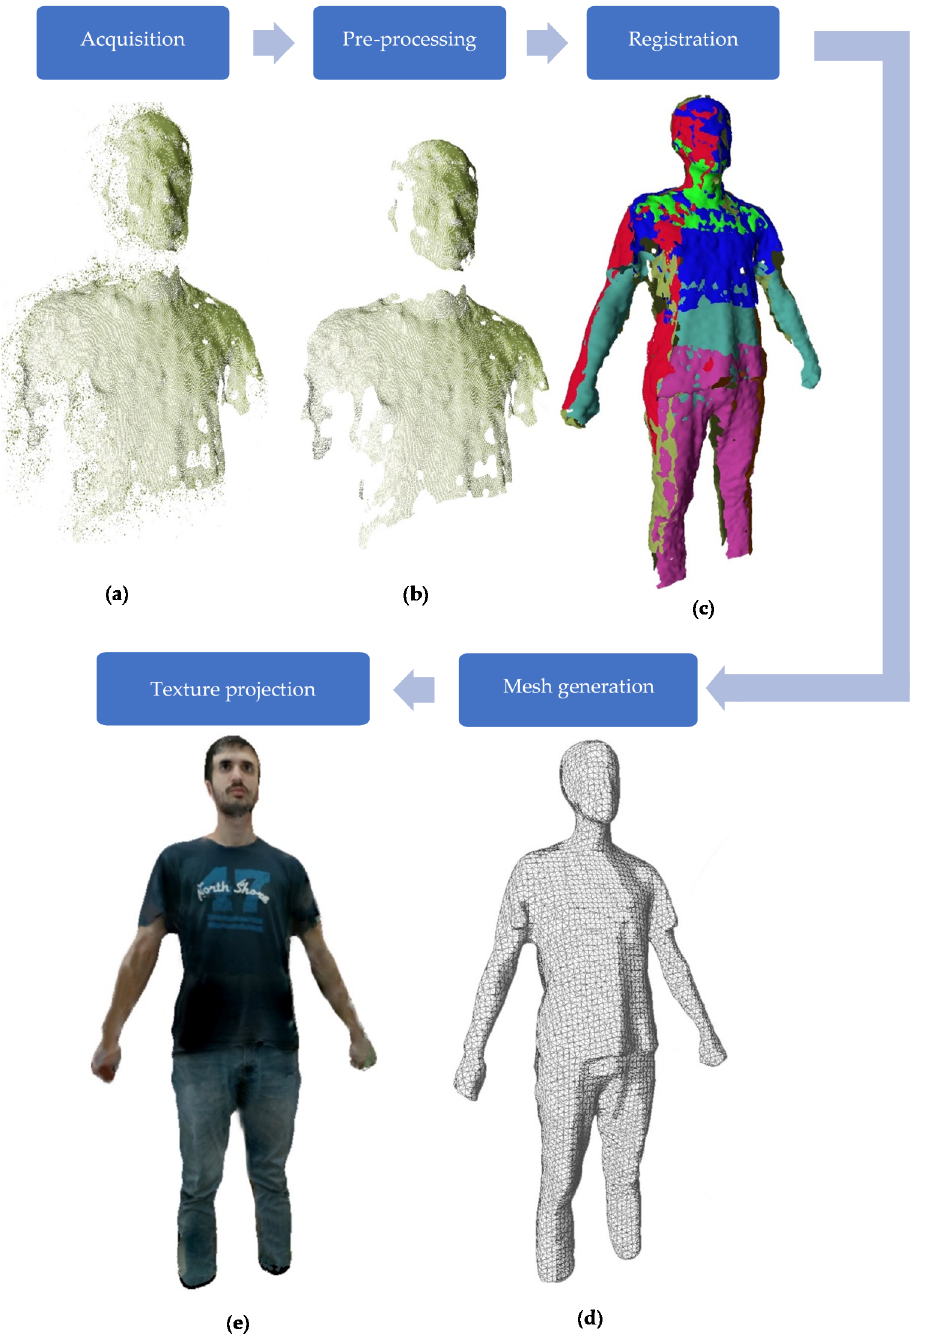
Figure 4. Pipeline of 3D body reconstruction. The system is able to acquire several images from cameras ( a ) that are preprocessed in order to improve the quality of the acquisition ( b ). The set of points are registered in a single coordinate system ( c ). Finally, in order to obtain the dense 3D model of the body, the 3D points are converted into a mesh ( e ) and the color images that were captured synchronously with the point cloud are texture-mapped onto the mesh ( d ) .